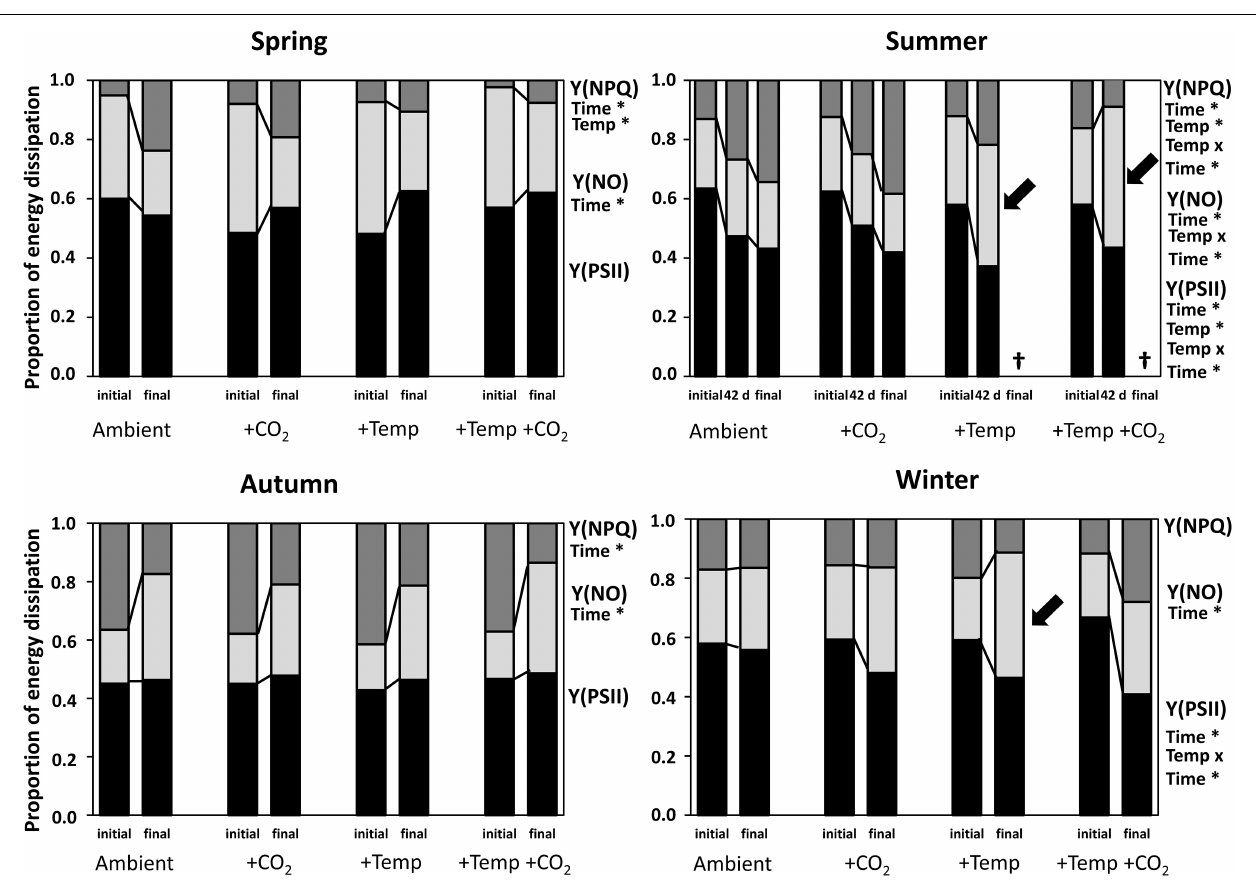
FIGURE 3 | Initial and final complementary energy dissipation pathways of Fucus vesiculosus during experiments in the Kiel Outdoor Benthocosms with various temperature and pCO 2 conditions over different seasons. Seasons: spring: April 4–June 19, 2013; summer: July 4–September 17, 2013; autumn: October 10–December 18, 2013; winter: January 16–April 1, 2014. Temperature and pCO 2 conditions: Ambient: ambient temperature and pCO 2 , +CO 2 : ambient temperature and elevated pCO 2 , +Temp: elevated temperature and ambient pCO 2 , +Temp +CO 2 : elevated temperature and pCO 2 . Y(PSII) = photochemistry (black bars); Y(NO) = energy dissipation (non-regulated non-photochemical quenching; light gray bars); Y(NPQ) = xanthophyll cycling (regulated non-photochemical quenching; dark gray bars). Values are means ( n = 3). Factors listed with an asterisk for each season and parameter are those shown by repeated-measures ANOVA to have significant effects. The statistics are related to the initial vs. final values ( Supplementary Tables 9–11 ). Cross ( † ) indicates dieback of F. vesiculosus in the summer experiment under warming. Black arrows indicate main increases in Y(NO) during summer and winter